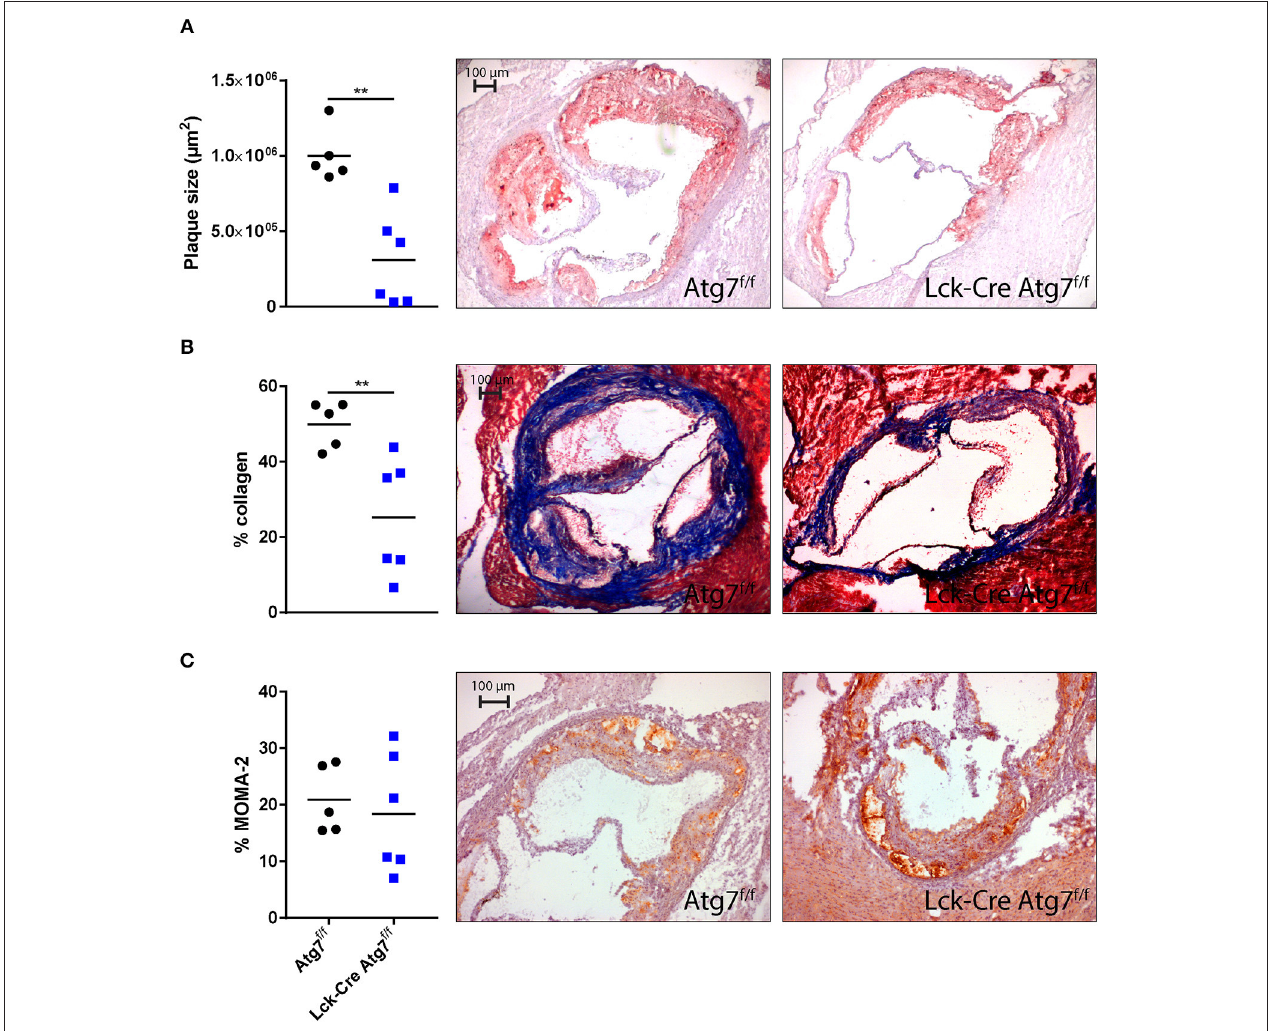
FIGURE 5 | Histological analysis of atherosclerosis in the aortic root. (A) Quantification of mean plaque size using Oil-red-O staining. (B) Quantification of collagen content using a Masson’s Trichrome staining. Collagen fibers are indicated in blue. (C) Quantification of monocyte-macrophage content using a MOMA-2 antibody. ** p <